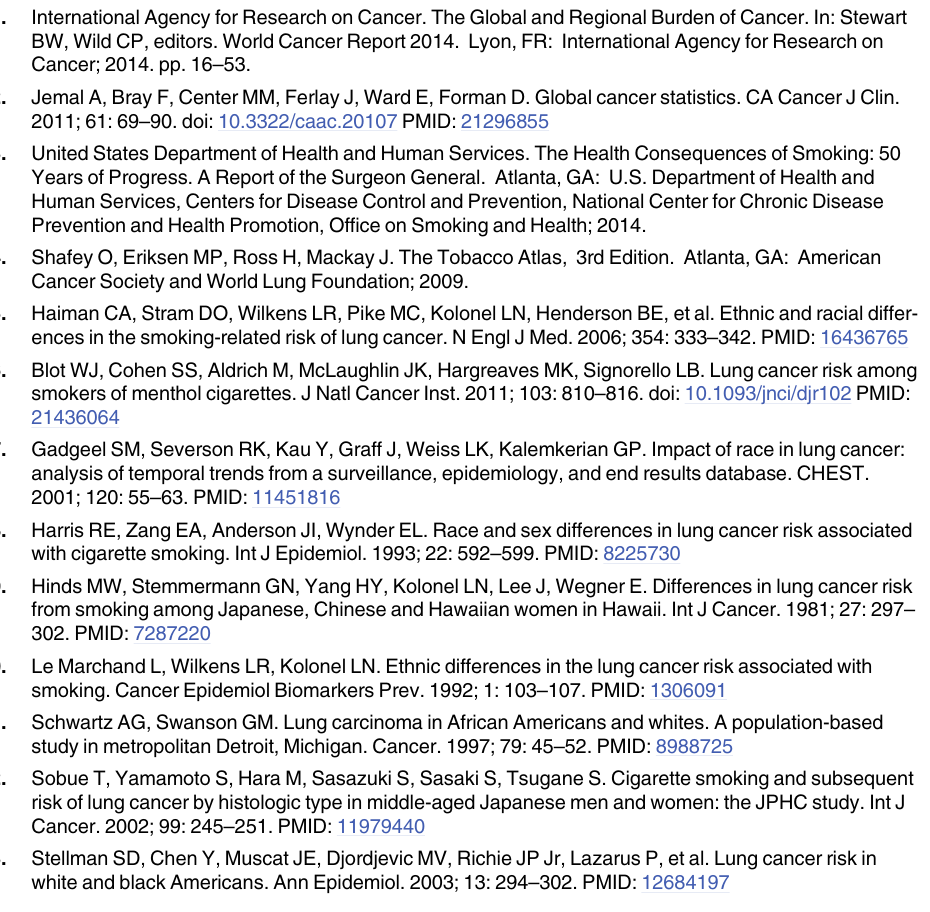
S1 Fig. Quantile-Quantile plot of the GWAS results for 3-HPMA. Genome-wide significance is defined as the Bonferroni corrected 5% significance threshold (p-value < 5.0×10 − 8 ). (JPG) S2 Fig. Quantile-Quantile plot of the GWAS results for HMPMA. Genome-wide signifi- cance is defined as the Bonferroni corrected 5% significance threshold (p-value < 5.0×10 − 8 ).